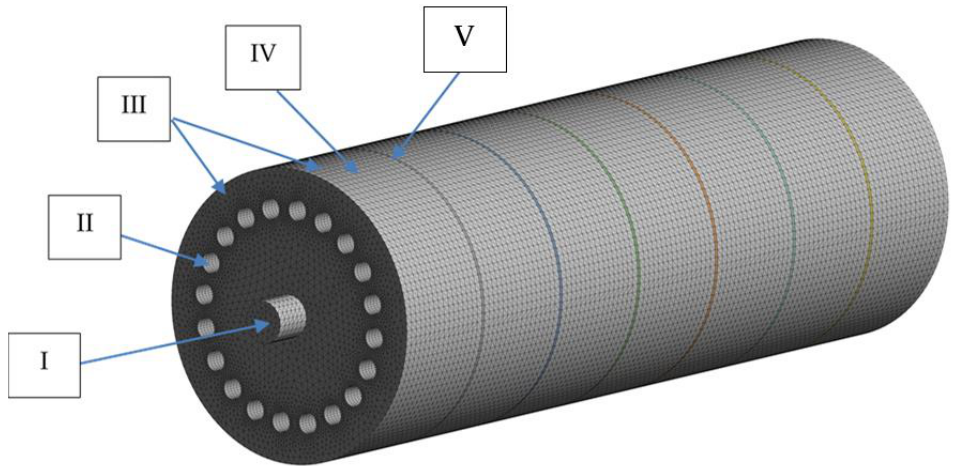
Figure 3. Mesh model and boundary conditions for shell-side flow test problems.